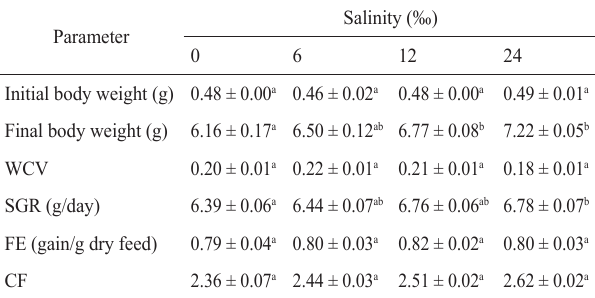
Table 1. Body weight, weight coefficient variation (WCV) specific growth rate (SGR), feed efficiency (FE) and condition factor (CF) in juvenile Lebranche mullet Mugil liza maintained in different salinities for 40 days 1 . 1 Data are expressed as mean ± standard error (n = 20). Different letters denote significant difference among treatments for the same parameter (p <